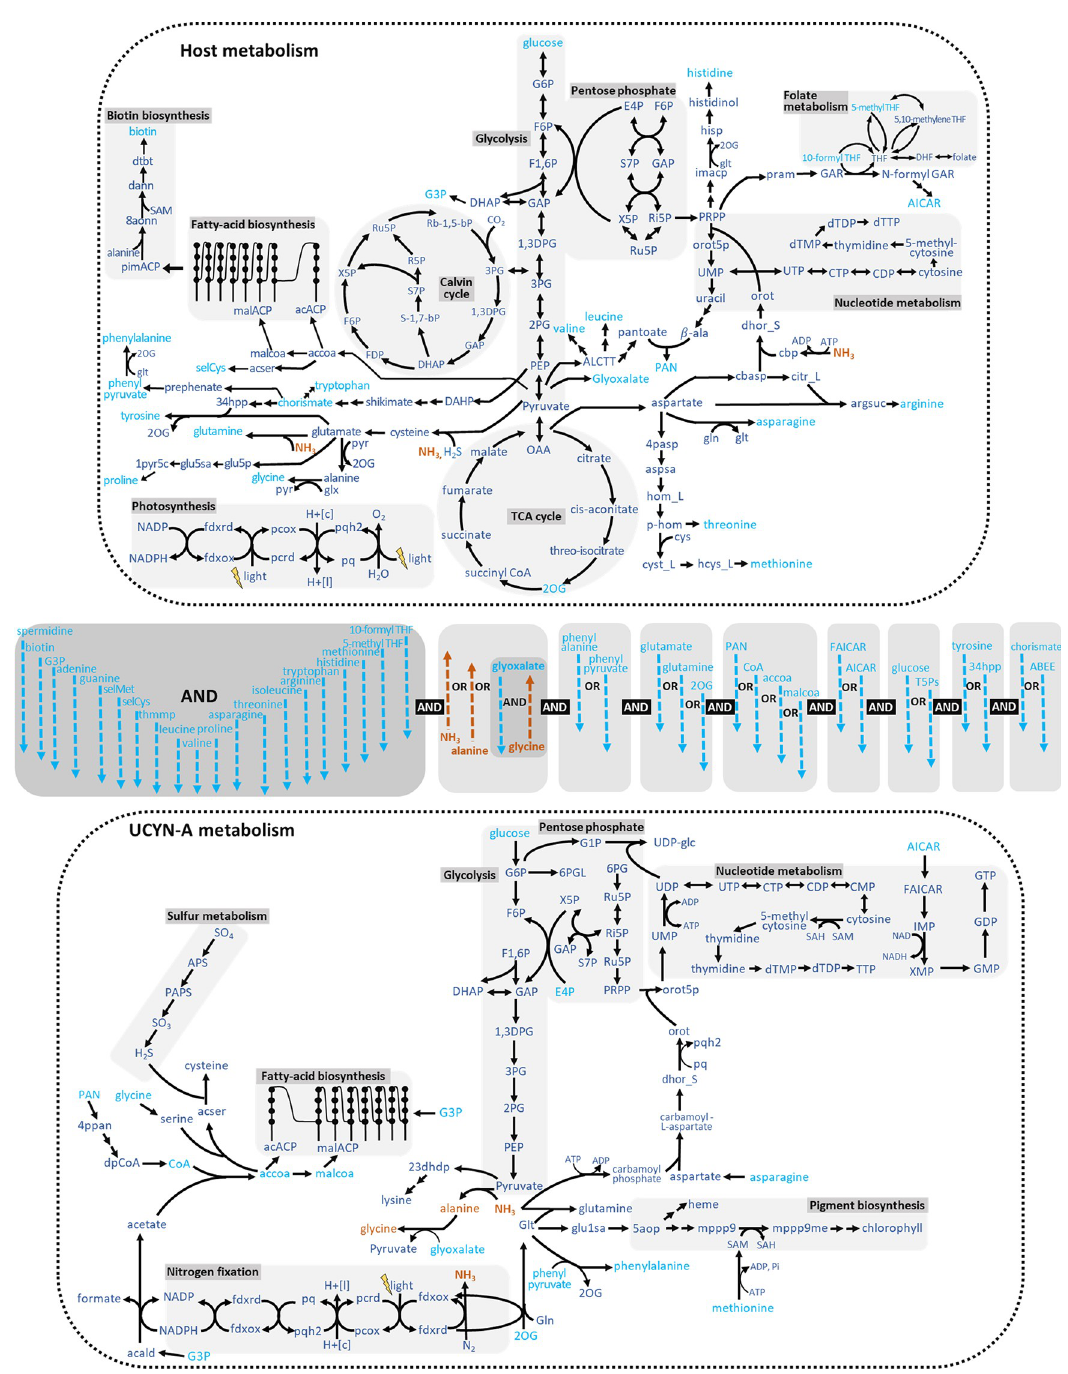
Fig 1. Summary of the metabolite predicted exchanges between UCYN-A and its host. Metabolic pathway diagram showing symbiosis between the algal host (top) and UCYN-A (bottom). Metabolite transfers are grouped using Boolean statements wherein metabolites which must be transferred simultaneously to realize biomass synthesis are shown using an AND statement and metabolites which represent alternate trophic scenarios are shown using an OR statement. Metabolites transferred from the host are marked in cyan while metabolites transferred from UCYN-A are shown in orange. Host metabolites that must necessarily be transferred have been grouped together using an AND statement (left-most block, shown in dark grey). Metabolites IDs conforming to the BiGG database have been